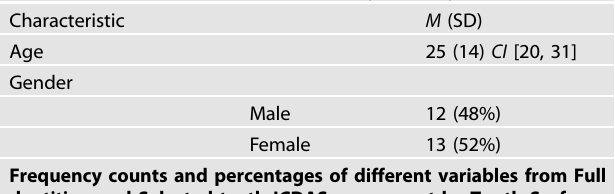
Table 3. Frequency of Analysis on Demographic information and Frequency counts and percentages of different variables from Selected study teeth and Full dentition ICDAS assessment by tooth Surfaces.